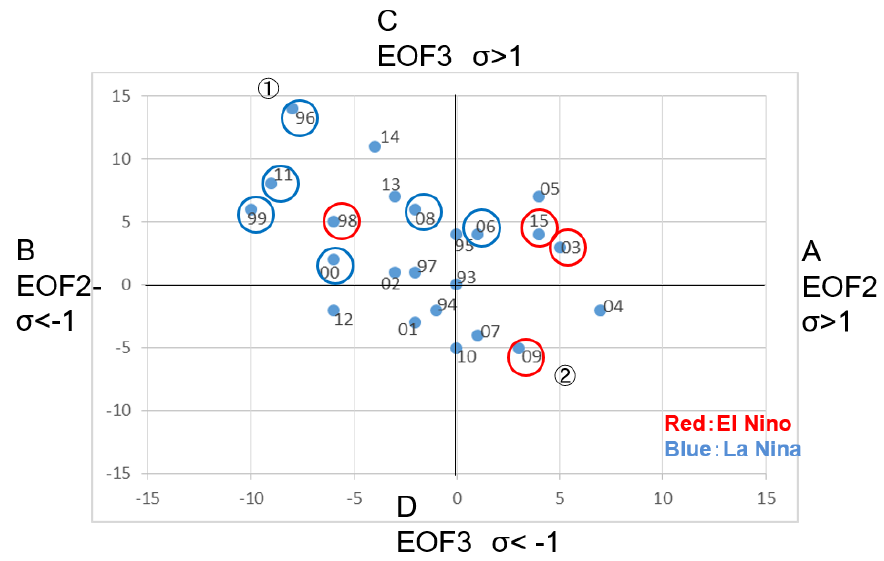
Figure 9. Frequency of each mode (number of days on which the absolute score exceeds 1). Numbers indicate year (e.g., 98 means the 1997/1998 winter). Red/blue circles indicate El Niño/La Niña winters.